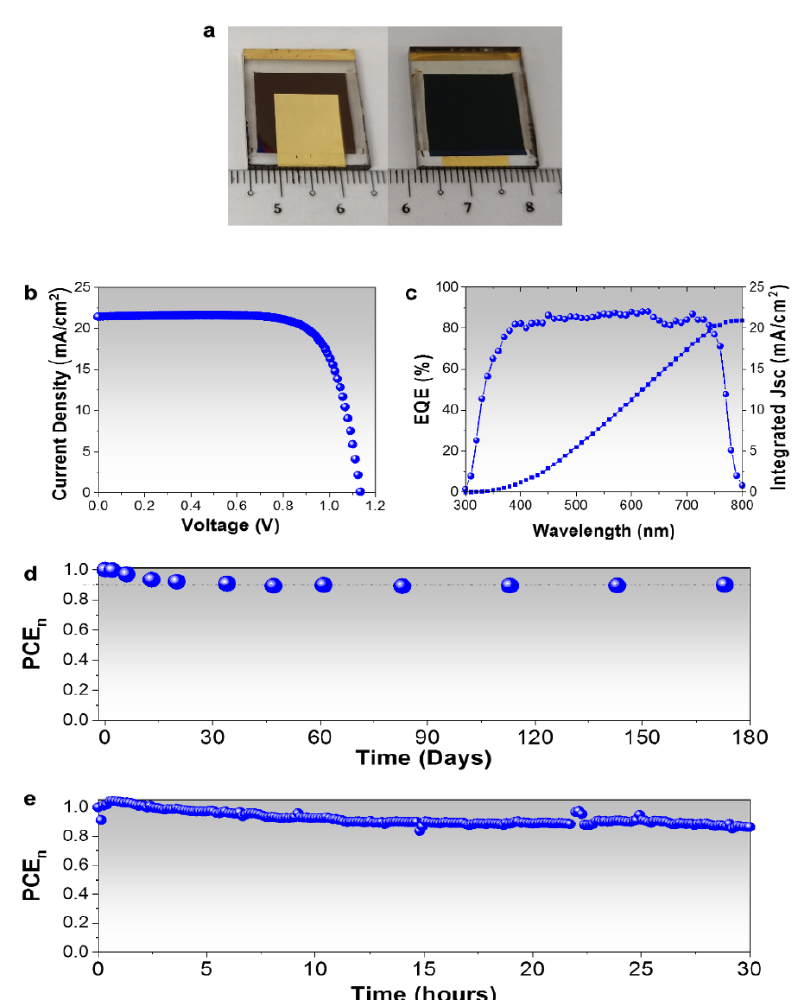
Figure 3. The 1 cm 2 treated-MAPbI 3 PSC. ( a ) Photograph of 1 cm 2 PSCs taken from both the front